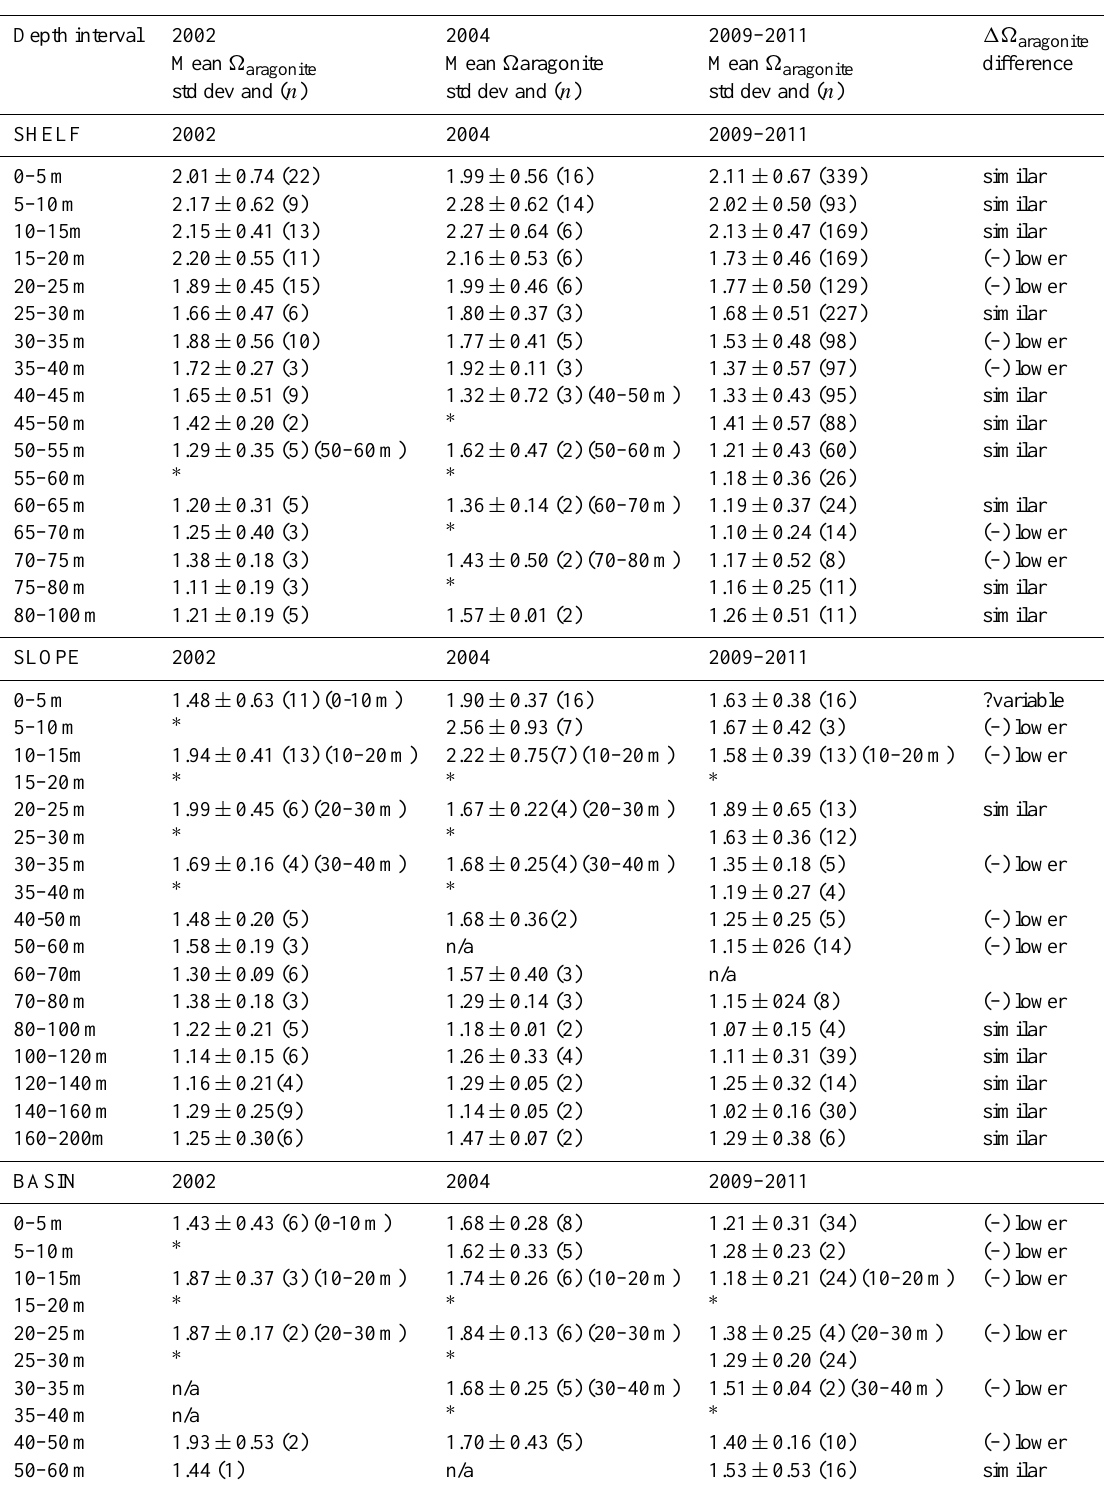
Table 1. Mean (cid:127) aragonite values at different depth intervals for shelf, slope and basin waters in the western Arctic Ocean. The mean, standard deviation and number of samples (bracketed) are given for summertime cruises in 2002 (SBI), 2004 (SBI) and 2009–2011 (RUSALCA/ICESCAPE). The last column denotes the difference between 2009–2011 data and earlier SBI (cid:127) aragonite data. We note “similar” if the mean of the 2009–2011 (cid:127) aragonite data is within 10% of one or more earlier years. ∗ denotes this depth interval incorporated into mean value